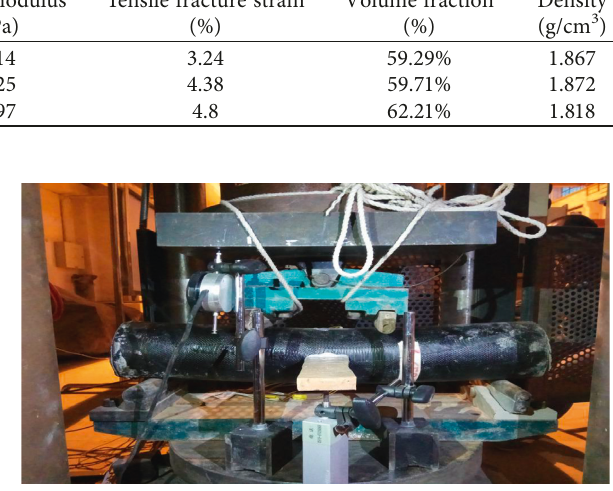
Figure 3: Setup of the four-point bending